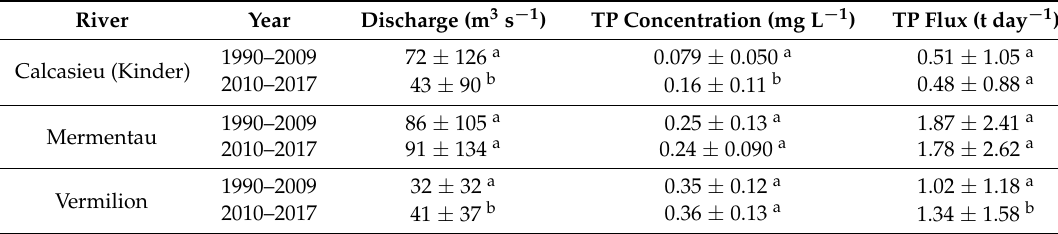
Table 5. Comparison between total phosphorus loading from 1990 to 2009 and from 2010 to 2017. Means followed by the same superscript letter (a or b) within a column for the same river are not significantly different at the 0.05 level, and vice versa. Only non-negative discharge data were used to calculate phosphorus flux and perform statistical analysis here. Data for 1990–2009 are from He and Xu [7]. TP concentration data used are all from LDEQ to keep the data source consistency. The sampling size used to calculate mean TP concentration for the Calcasieu, Mermentau, and Vermilion Rivers during 2010–2017 are 14, 53, and 78,